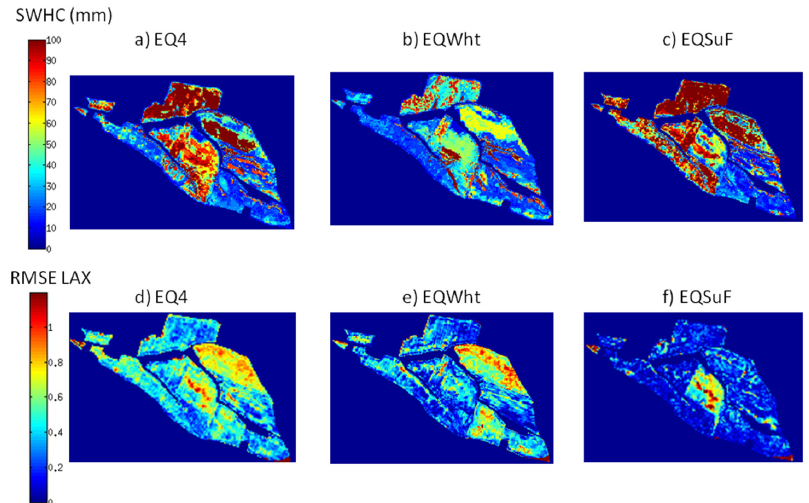
Figure 6. The optimal SWHC derived by minimizing the distance between observed and synthetic LAX over ( a ) four years (2007–2010); ( b ) two years for winter wheat (2007 and 2009); and ( c ) two years in Sunflower (2008 and 2010) are presented. The RMSE computed between observed and simulated LAX is presented for each method ( d – f ). RMSE around 1 corresponds to 25% of the maximum LAI (max(LAX) = 4) observed for the studied crops.